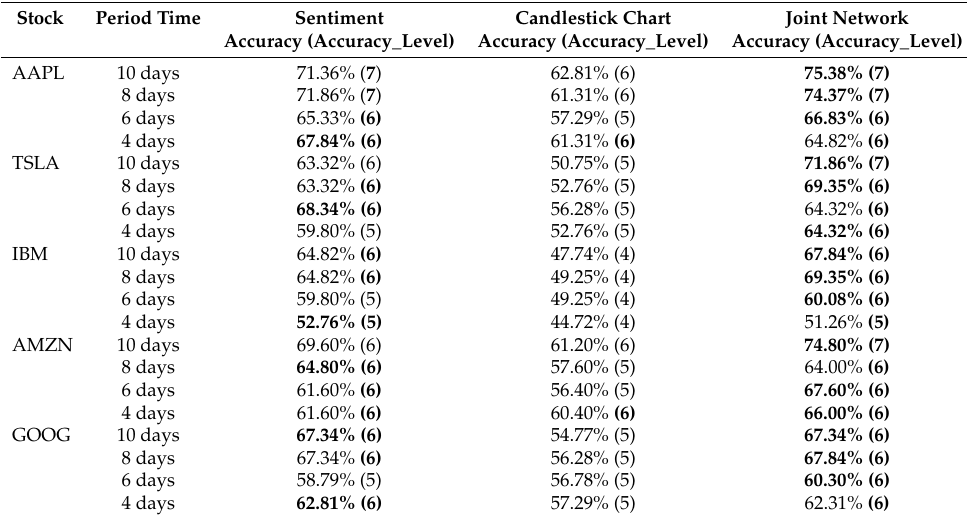
Table 5. Accuracy improvement in stock trend prediction based on the joint network.